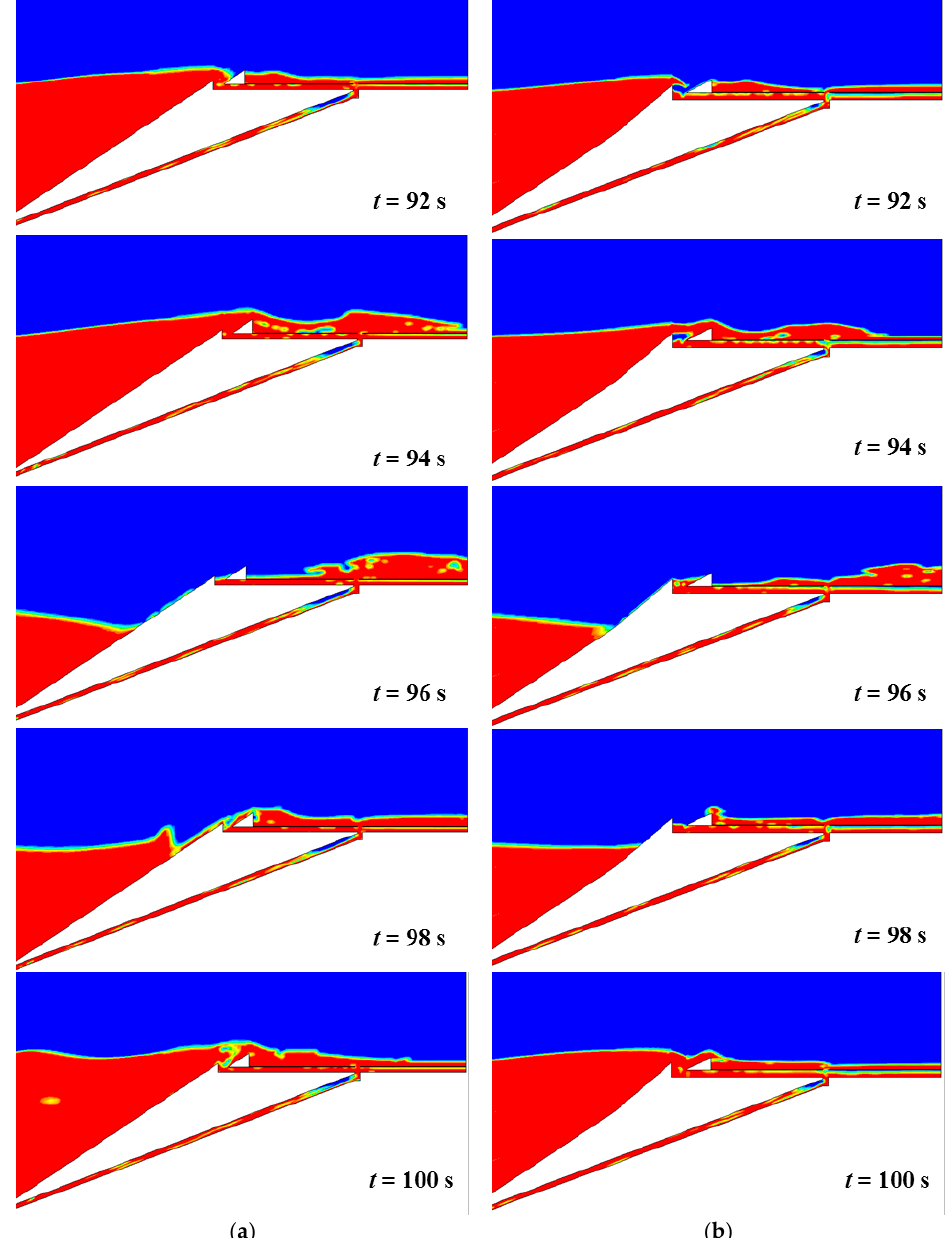
Figure 28. Hydrodynamic behavior of transient fluid flow for the instants t = 92–100 s: ( a ) case 38; ( b ) case 59.